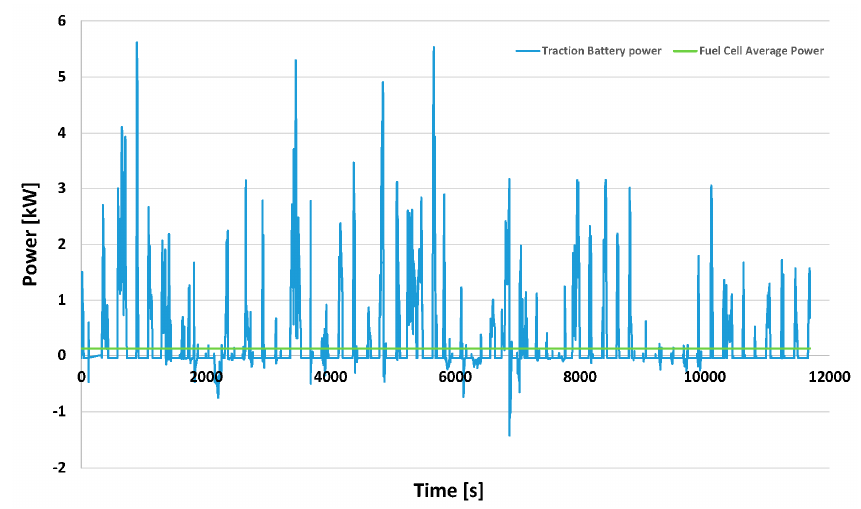
Figure 16. Instantaneous power of Traction Battery and Fuel Cell.